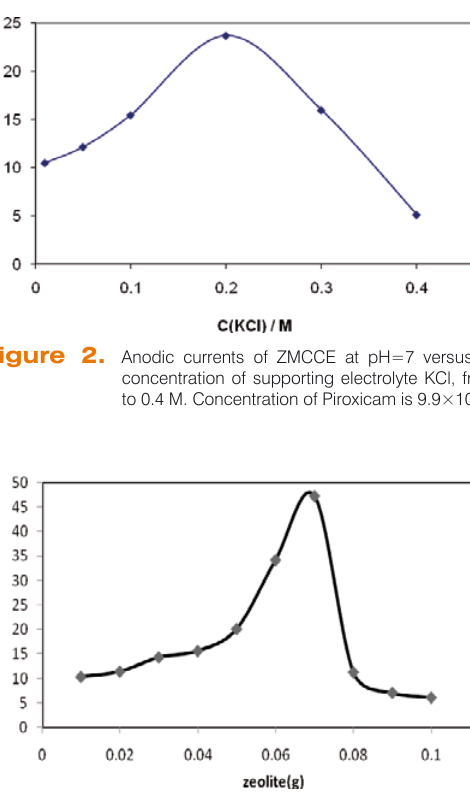
Figure 3. The effect of the amount of zeolite at pH=7 on the ZMCCE performance toward electrooxidation of pyroxicam. Concentration of Piroxicam is 1.9 × 10 -5 M. (Figs. 1 b and 1 c, respectively). The voltammogram of d in Fig. 1 is the background for CCZME. Comparing data at the CCE and CPZME, an increase in peak current and a decrease in the overpotential of Piroxicam are obtained at the CCZME modifi ed electrode. These values indicate electrocatalytic oxidation of Piroxicam at the CCE modifi ed with zeolite.